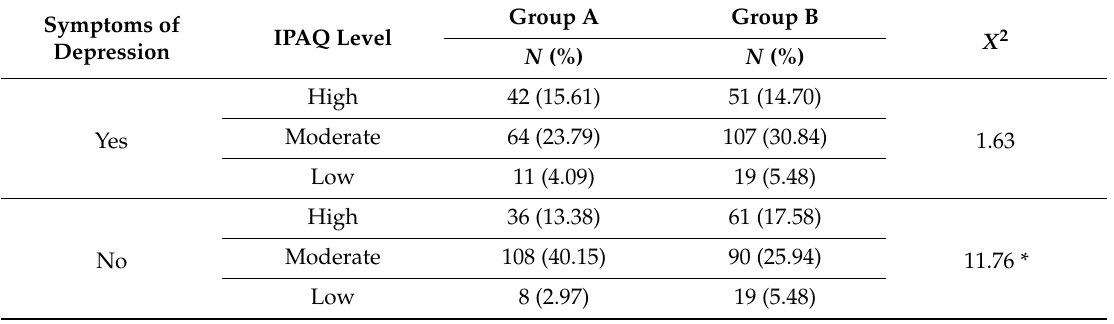
Table 4. Comparison of the study group (group A) and control group (group B) for symptoms of depression and level of physical